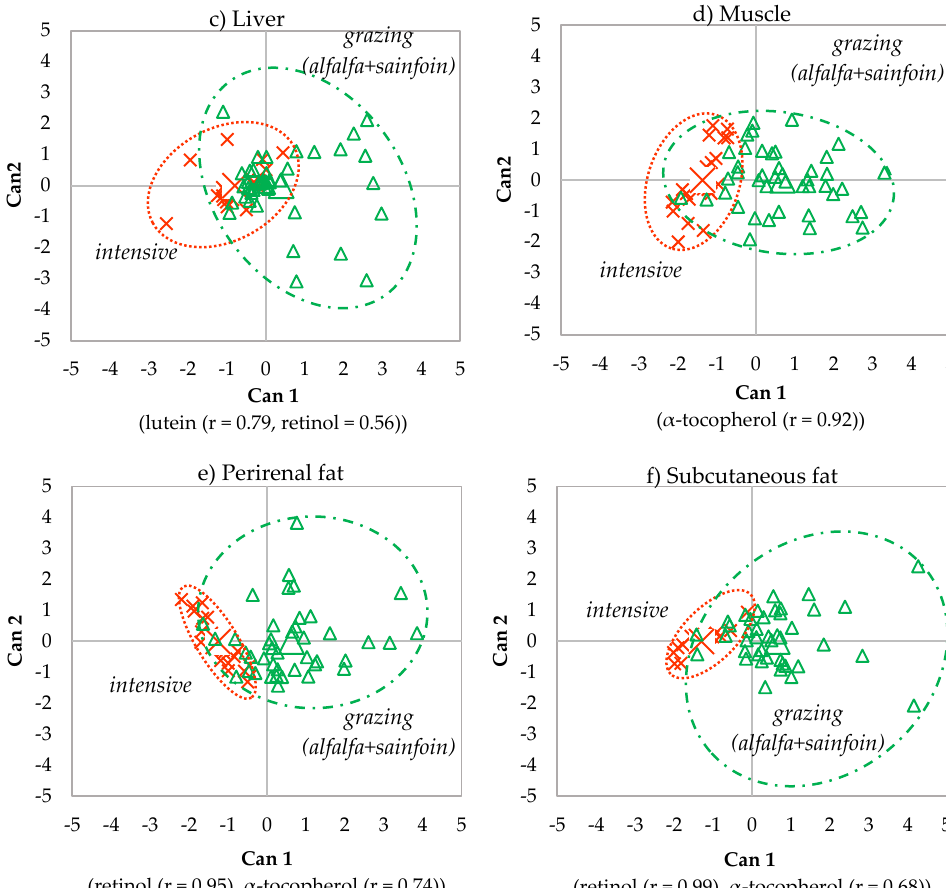
Figure 5. Canonical discriminant plots between maternal feeding (intensive vs. grazing) in the plasma at slaughter ( a ), whole carcass ( b ), liver ( c ), muscle ( d ), perirenal ( e ) and subcutaneous fat ( f ) using the analytes determined in each tissue.